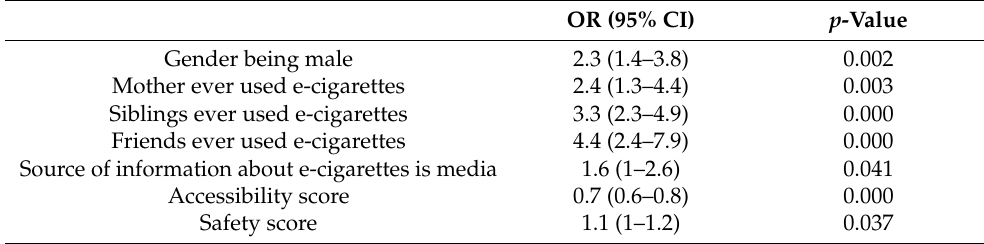
Table 6. Covariates Affecting Students from Health Professions Schools Being E-cigarettes Ever Users Using Logistic Regression